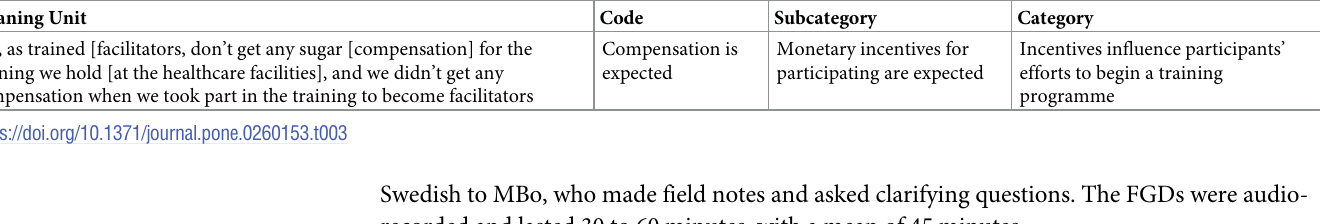
Table 3. Examples of the data analysis process from meaning unit to category. Meaning Unit